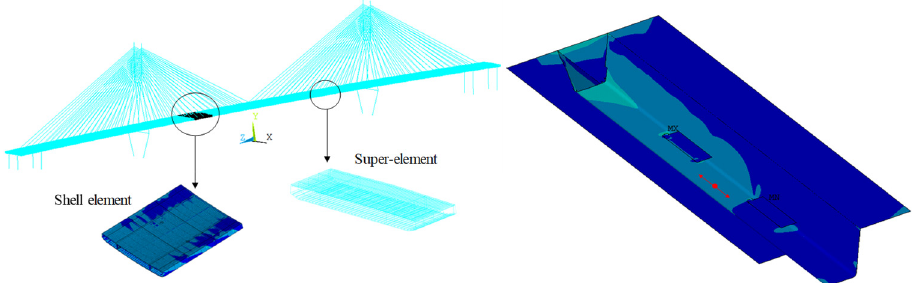
Figure 7. Multi-scale finite element model and nominal stress extraction of the investigated long-span cable-stayed bridge.